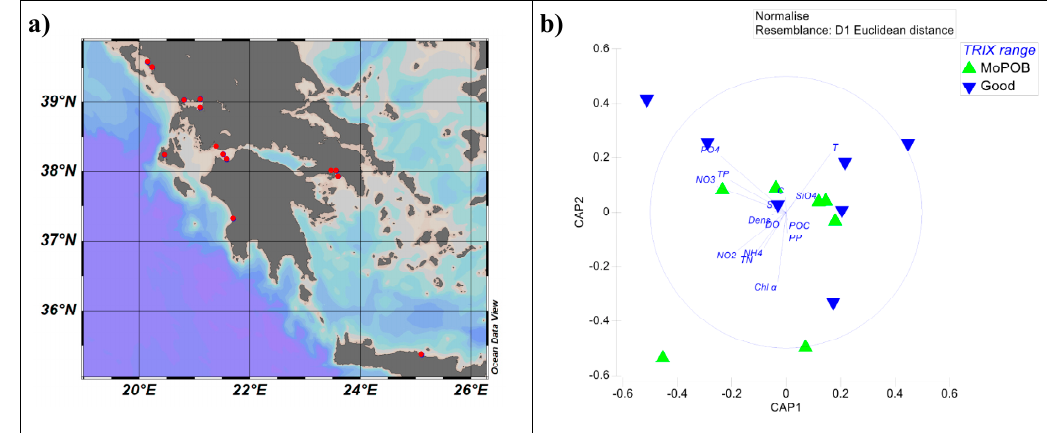
Figure 1. ( a ) Map of the sampling stations in the Ionian and South Aegean seas. ( b ) Sample-grouping substantiation. Canonical analysis of principal coordinates (CAP) of the coastal seawater physicochemical variables (solid-lined circle), depicting the sample grouping based on the ecological quality and Pearson correlations of the physicochemical variables with the canonical axes. SiO4: silicate concentration, DO: dissolved oxygen concentration, POC: particulate organic carbon concentration, TN: total nitrogen concentration, TP: total phosphorus concentration, Chl α : chlorophyll α concentration, PO4: phosphate concentration, NO3 and NO2: nitrate and nitrite concentrations, NH4: ammonium concentration, Dens: density, C: conductivity, S: salinity, T: temperature. Stations are colored based on the annual surface trophic index (TRIX) range and named after “Good” (blue) when having overall good ecological quality (TRIX = 1.6–2.8), and “MoPoB” (green) when having overall poor ecological quality (TRIX > 2.8).